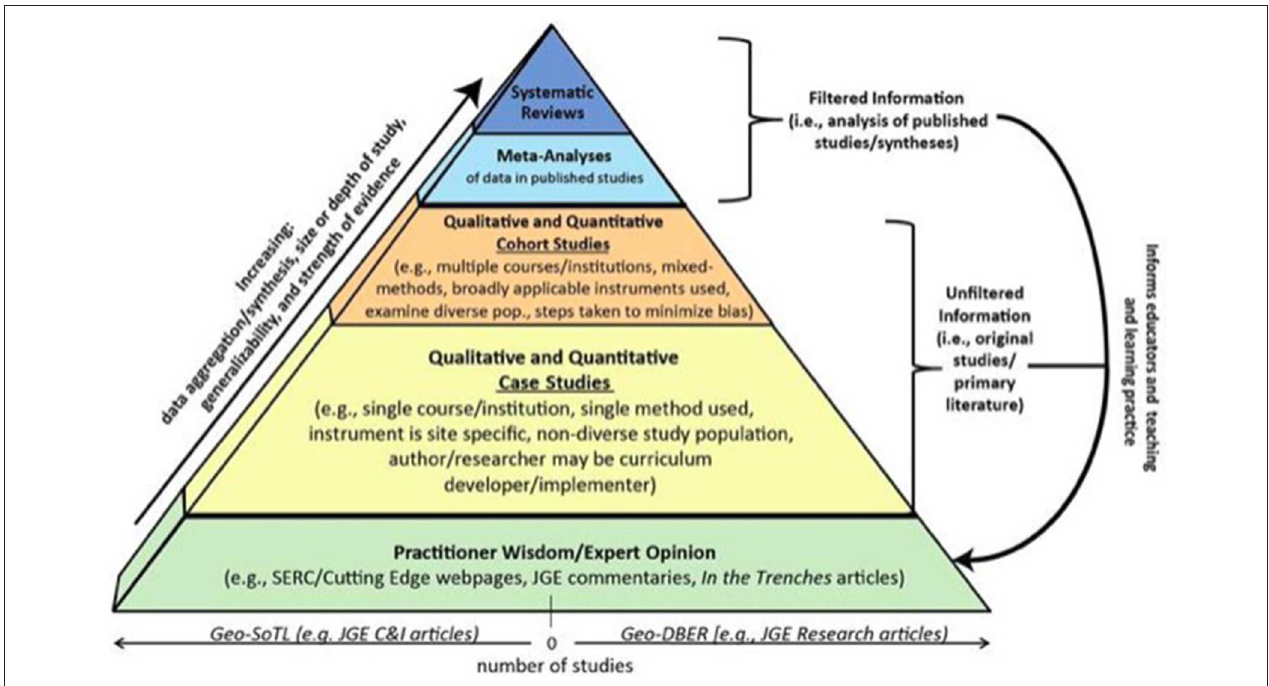
FIGURE 1 | The strength of evidence pyramid (John and McNeal,